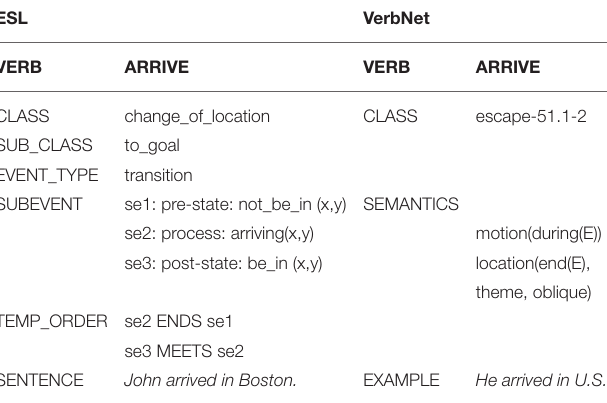
TABLE 1 | arrive in ESL vs.